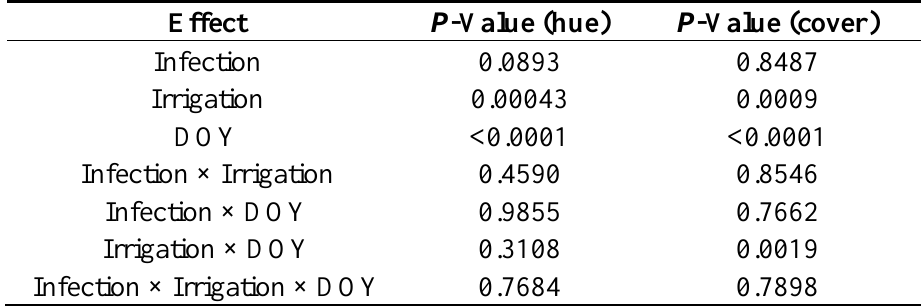
Table 2. Tests of fixed effects for 2011 wheat threshold-based hue and cover fraction (N =